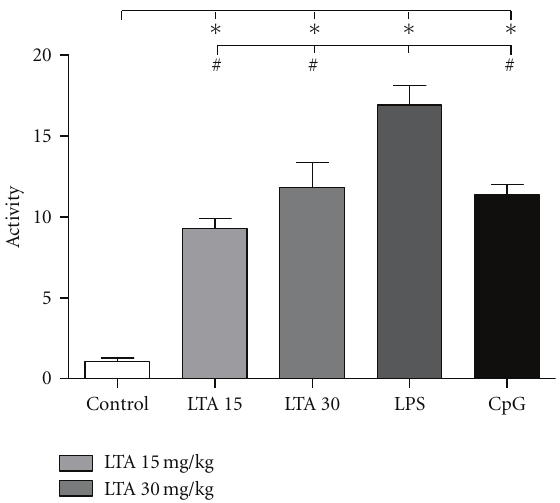
Figure 5: Myeloperoxidase activity in pulmonary tissue. Level of myeloperoxidase activity (x-fold of control) in lung tissue from control, LTA-, LPS- or CpG-treated mice 4h after stimulation ( ∗ P < . 01 versus control, # P < . 01 versus LPS; M ± SEM; n = 5/group).